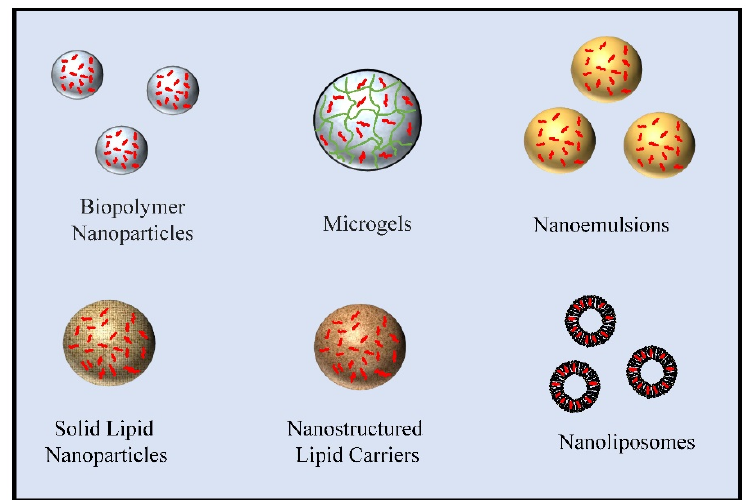
Figure 2. Schematic diagram of different types of delivery systems that can be assembled from plant-based ingredients.